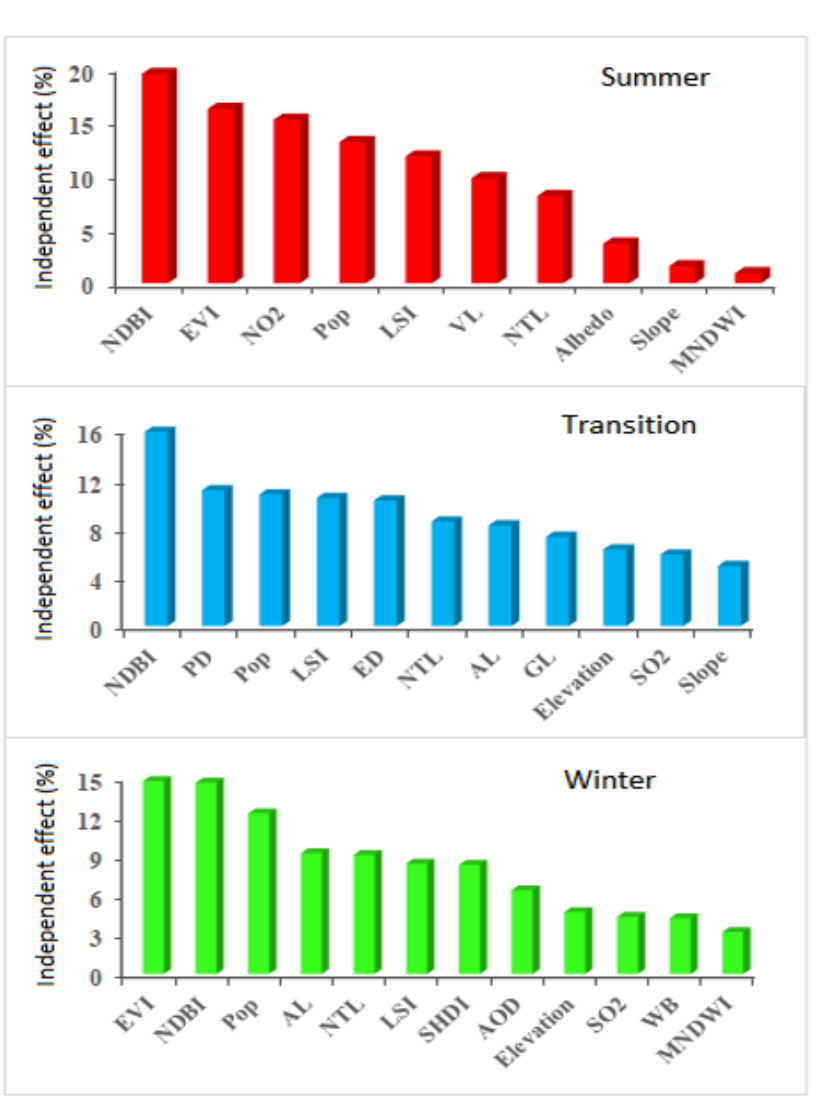
Figure 9. Figure 9. Independence effects of influencing factors to explain the variability of LST in the different seasons.